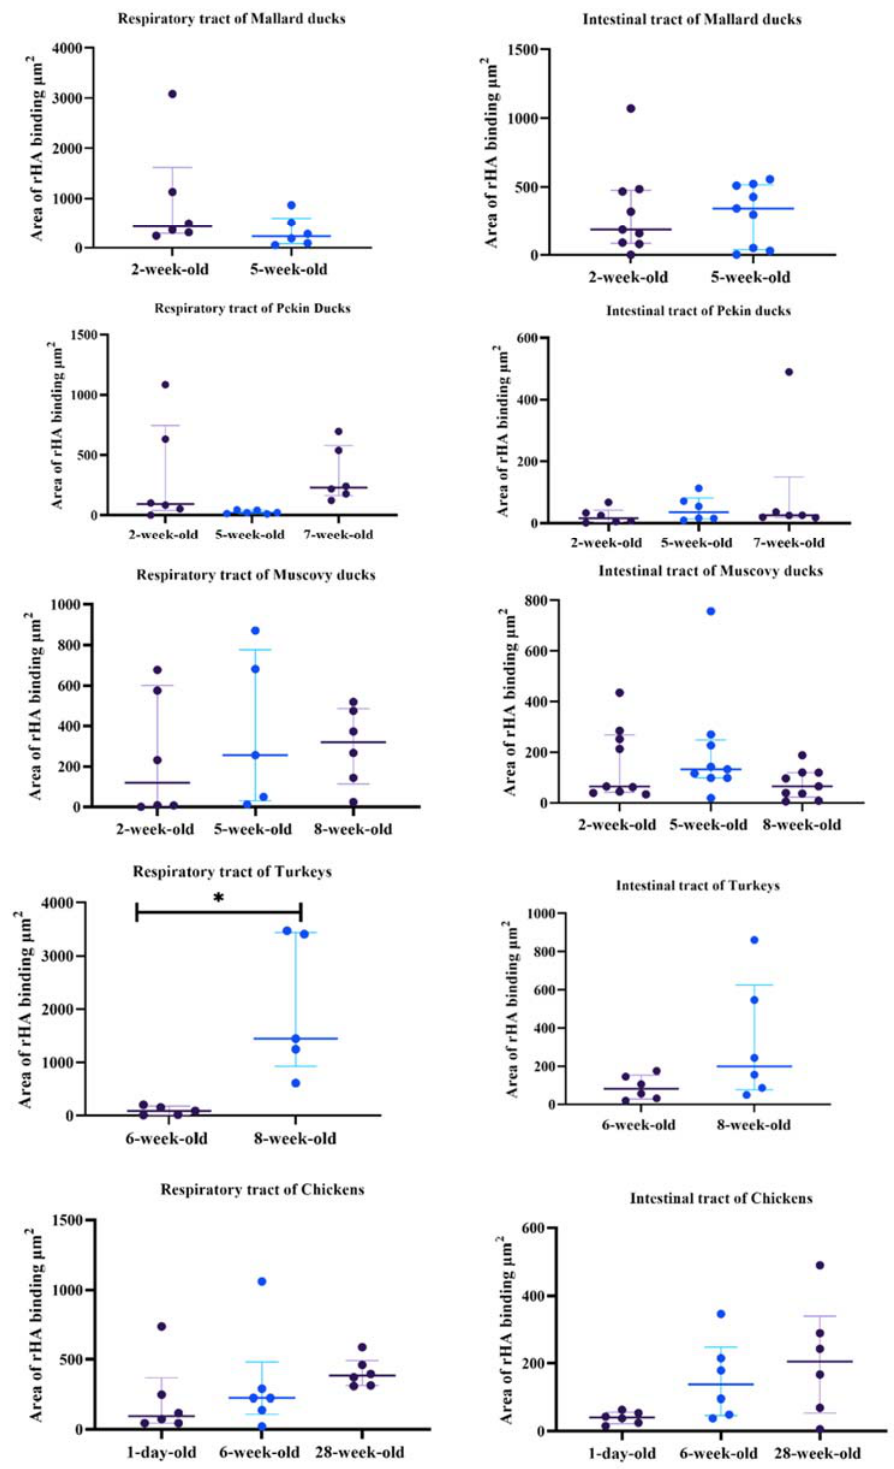
Figure 10. Dot plot charts show the binding scores of LPAIV rHA binding to the respiratory (trachea and lung) and intestinal tract (upper and lower intestine) of Mallards, Muscovy ducks, Pekin ducks, chickens, and turkeys. Dots represent the binding score for each tissue. A significant difference is seen only in the respiratory tract of turkeys. Statistical significance denoted by asterisk and bars. Kruskal–Wallis test and Mann–Whitney U test ( p ≤ 0.05). Graphs formulated in Graph Pad Prism 9.0.0. (GraphPad Software, San Diego, CA, USA).